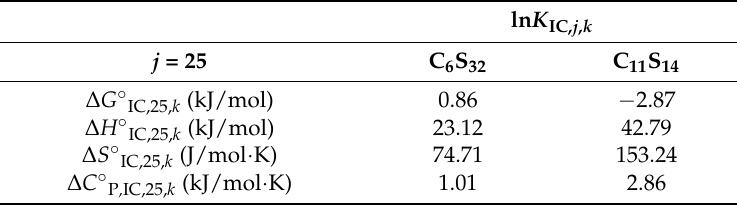
Table 4. Thermodynamic parameters of ln K IC, j , k of C n S m polymers at T = 25 ◦